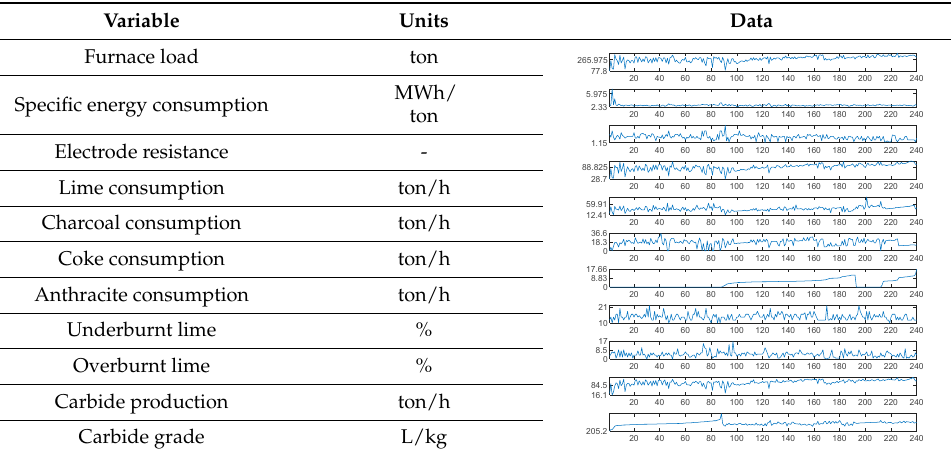
Table 1. Calcium carbide furnace data.